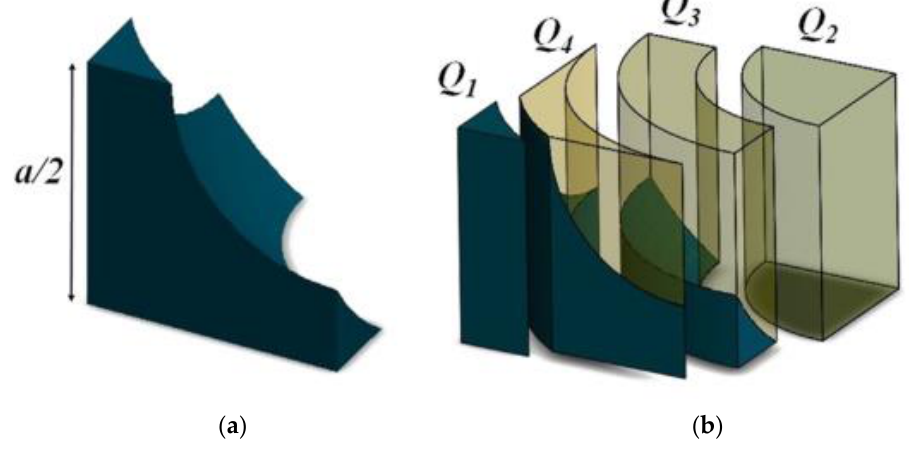
Figure 16. Cell: ( a ) Cell; ( b ) One-dimensional heat transfer.